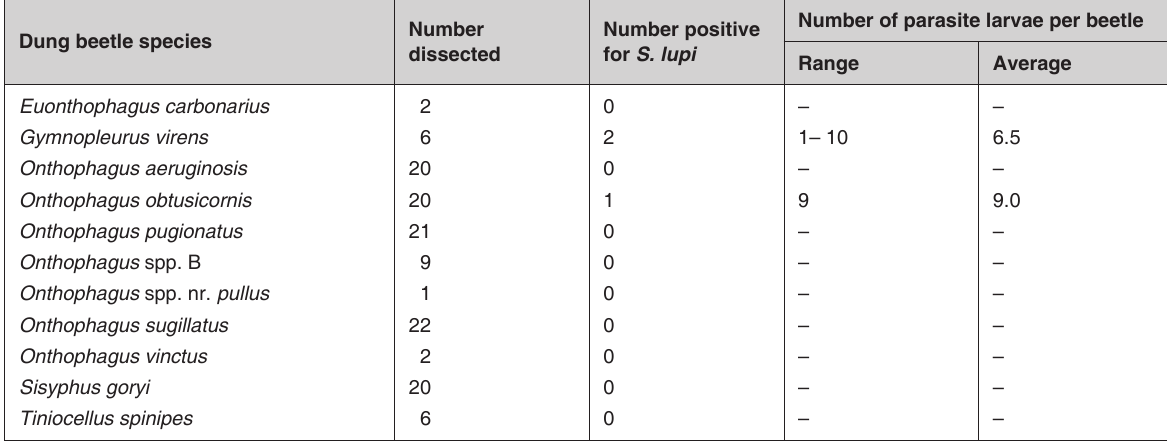
TABLE 3 Results of the dissection of various dung beetle species from a peri-urban area in the Tshwane (Pretoria) Metropole to in- vestigate the incidence of infection with Spirocerca lupi under natural conditions